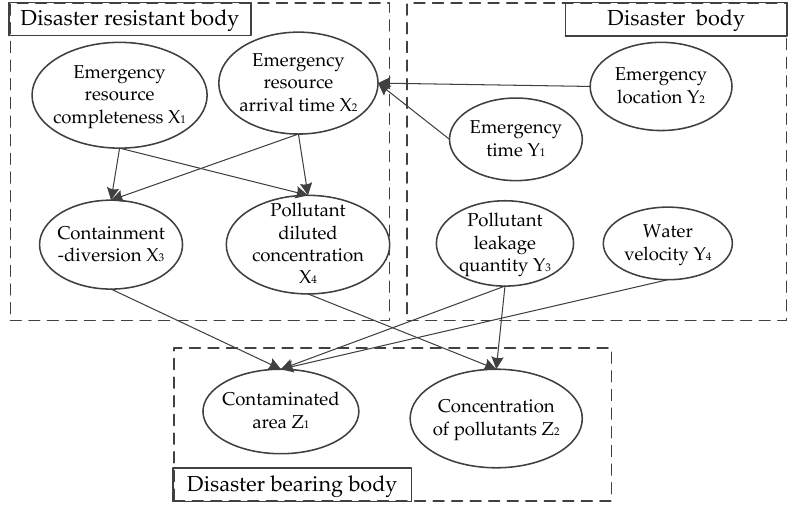
Figure 6. Bayesian network structure for scenario analysis of WEE.